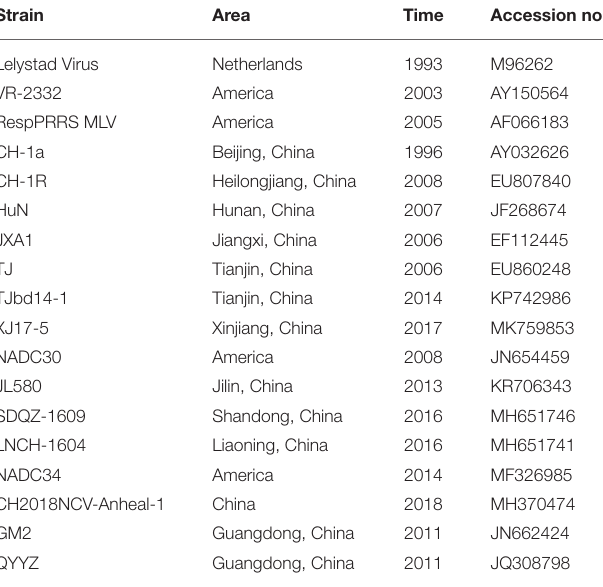
TABLE 1 | Primers used in this study.